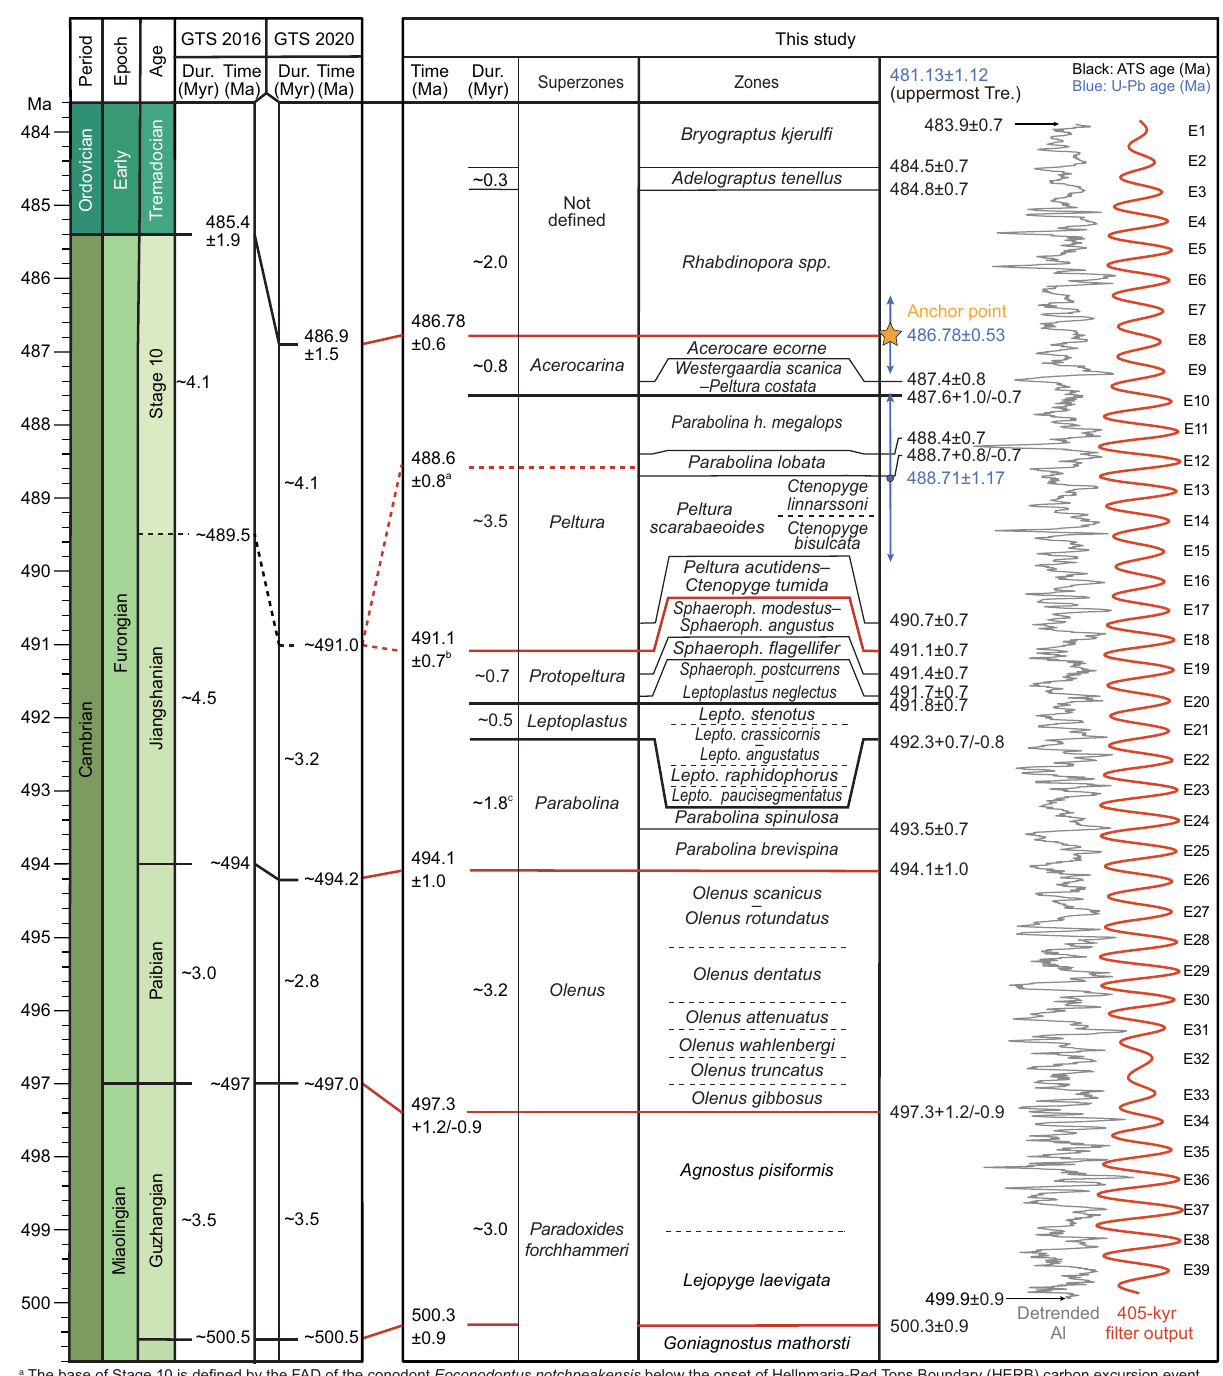
Fig. 4 Comparison between the radioisotopically anchored astronomical time scale and the international chronostratigraphic time scales. The age model was anchored to the U-Pb age of 486.78 ± 0.53 Ma for the Cambrian – Ordovician boundary 11,47 , and supported by the 481.13 ± 1.12 Ma for the uppermost Tremadocian 28,47 , and 488.71 ± 1.17 Ma for the upper Peltura scarabaeoides Zone 29,47 . The 405-kyr long orbital eccentricity cycles (red curve) were extracted using a bandpass Taner fi lter (passband: 0.00247 ± 0.00055